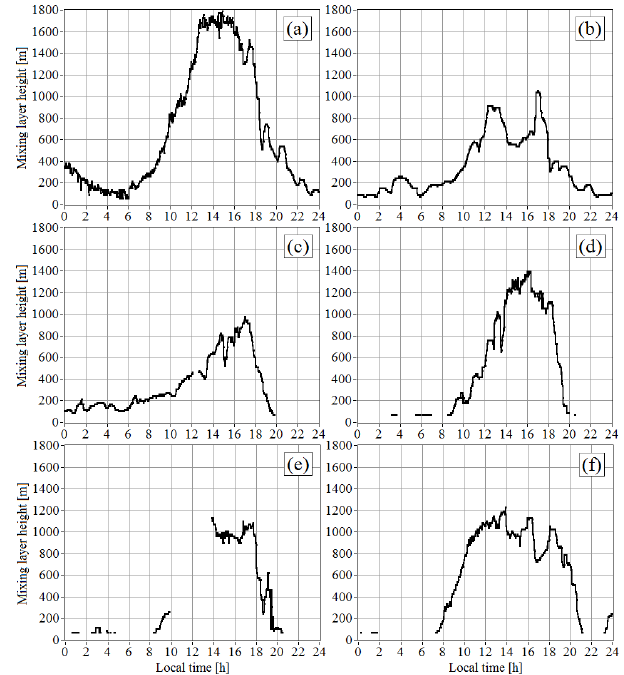
Figure 6. Time series of the turbulent mixing layer height (thick- ness) obtained from lidar data on 20 July (a) , 21 July (b) , 22 July (c) , 23 July (d) , 24 July (e) , and 25 July (f) of 2019.